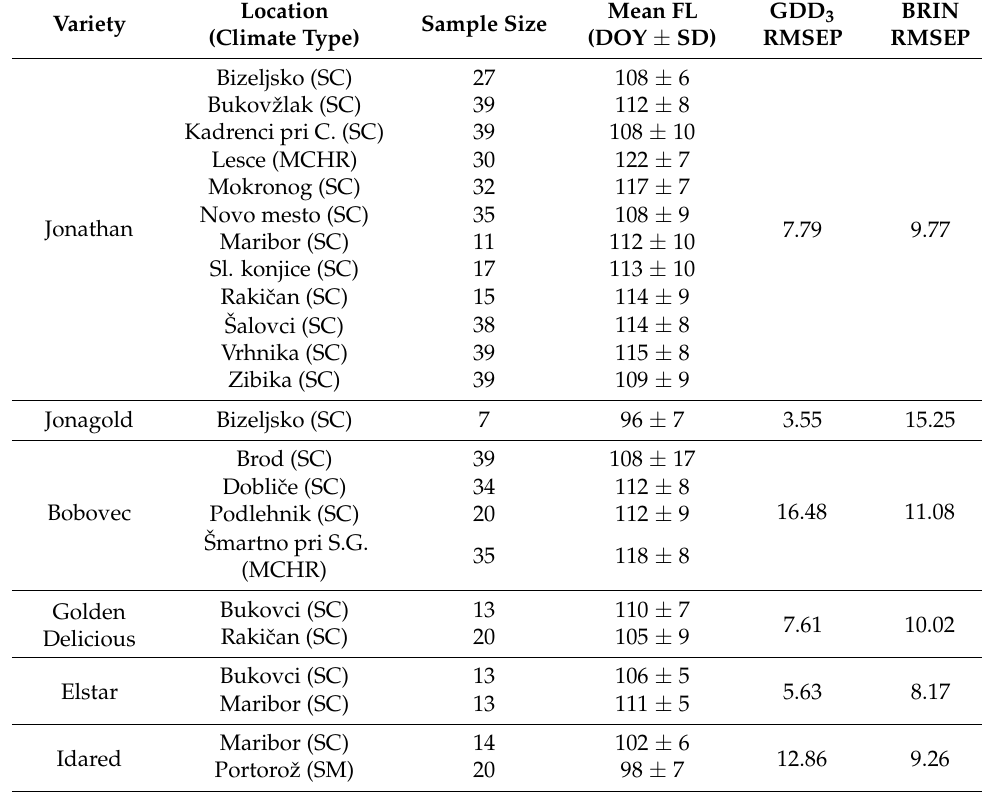
Table A1. Mean and standard deviation of observed historical flowering dates for the available sample sizes of several apple varieties, and the performance of GDD and BRIN models in modeling flowering dates. The assessment was made by calculating the root mean square error of prediction (RMSEP) and index of agreement (d) for the modeled and observed flowering dates. In both models, the base temperature is T b = 3 ◦